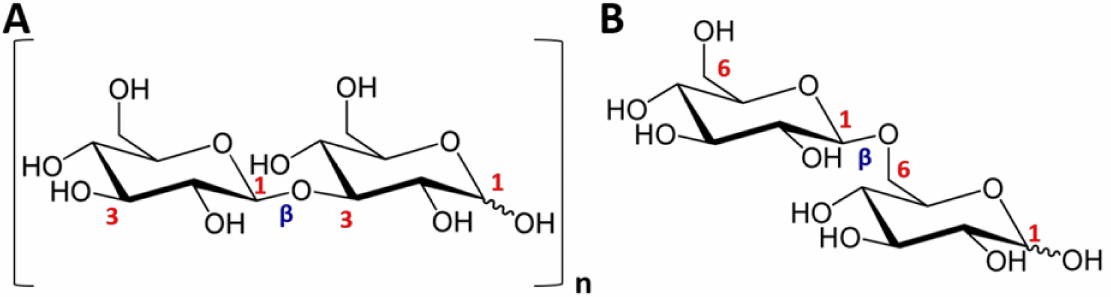
Figure 6. Structures of ( A ) laminaribioses and ( B )